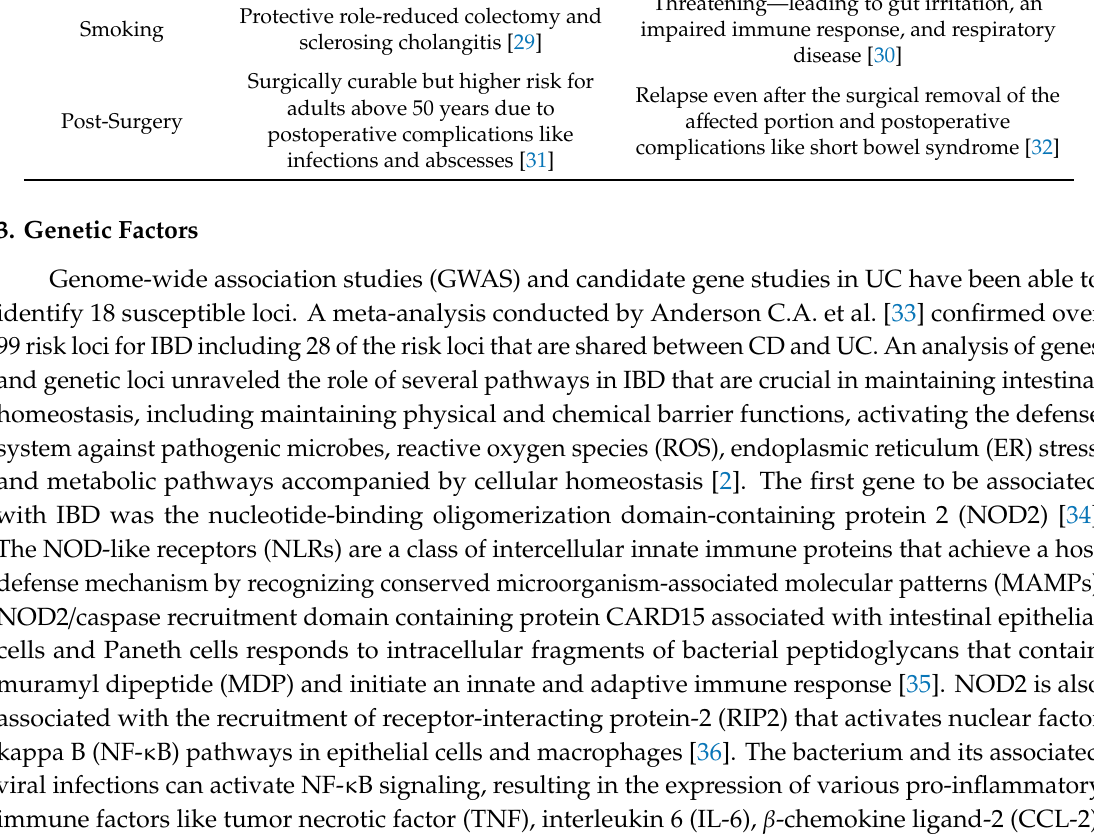
Protective role-reduced colectomy and sclerosing cholangitis